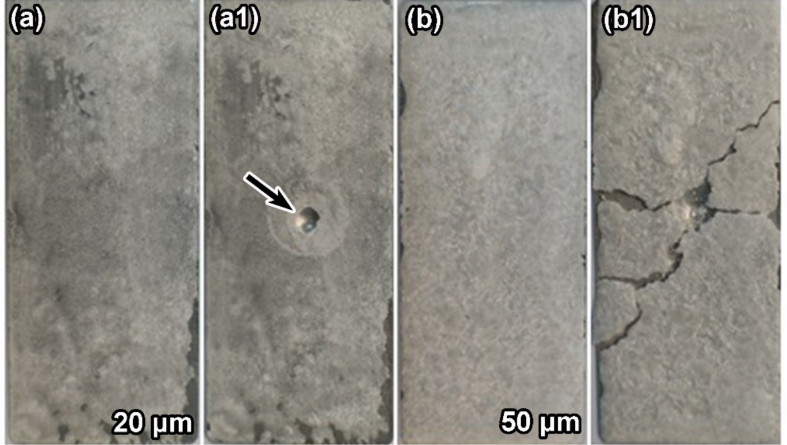
Figure 11. Photos of stearic acid-coated tinplate ( a , b ) before and ( a1 , b1 ) after the impact test: ( a , a1 ) the sealed film with a thickness of around 20 µ m, and ( b , b1 ) the sealed film with a thickness of around 50 µ m.